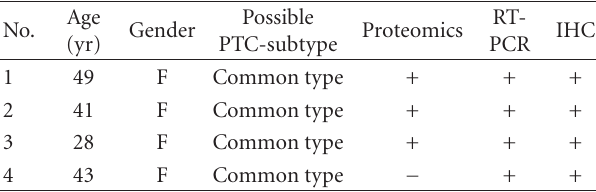
Table 1: Clinical details of analyzed tissue samples.